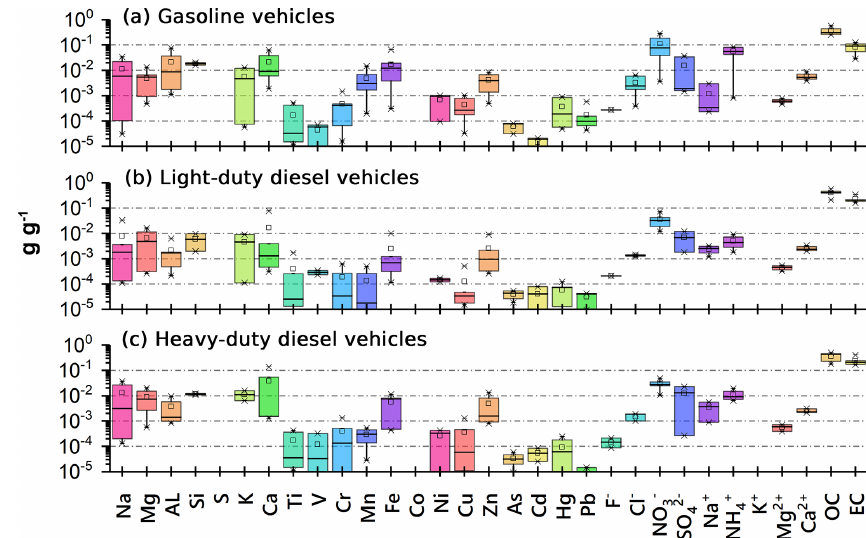
Figure 9. Chemical compositions of PM 10 source profiles from different vehicle types obtained using the direct sampling method. Data from the Nankai University source library and Chen et al. (2017b) were